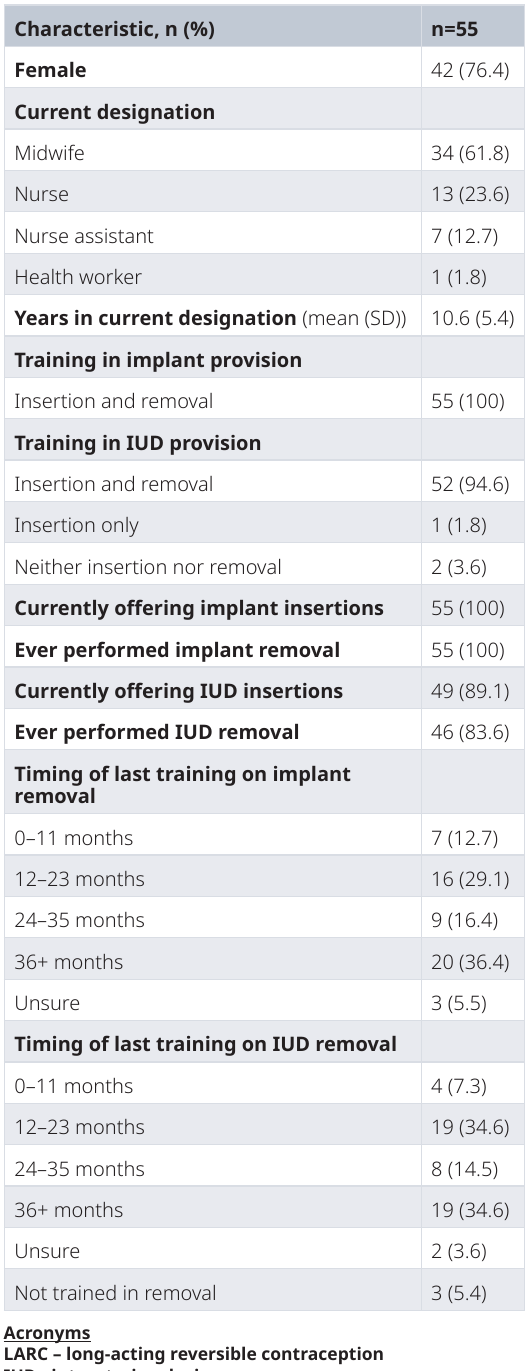
Table 1. Provider characteristics and LARC